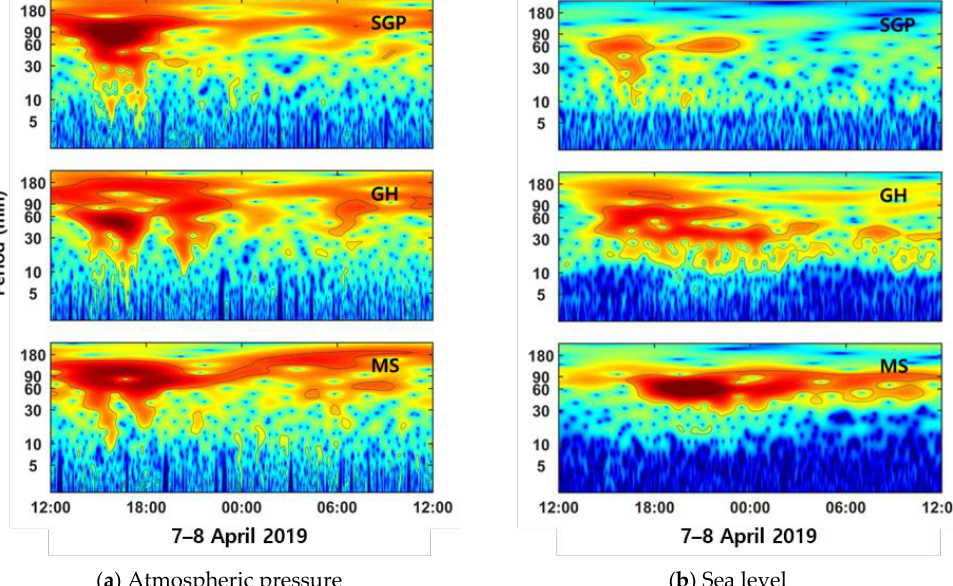
Figure 4. Wavelet spectrum of ( a ) atmospheric pressure and ( b ) sea level time series at the SGP, GH, and MS stations from 12:00 on 7 April to 12:00 on 8 April 2019. and MS stations from 12:00 on 7 April to 12:00 on 8 April